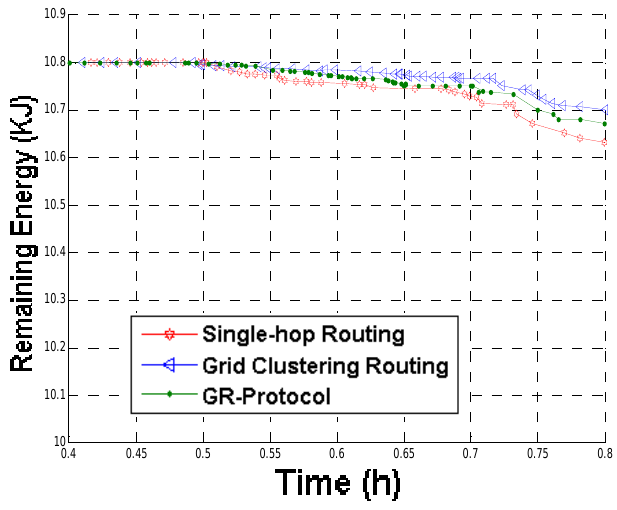
Figure 14. Remaining energy after first charge cycle.